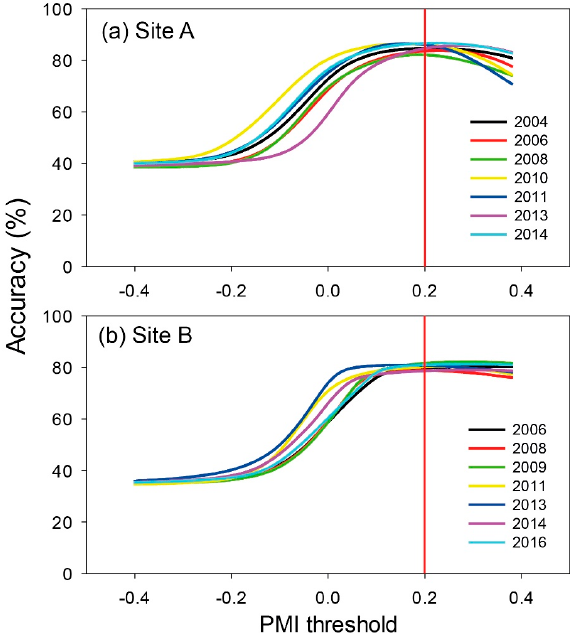
Figure 6. Threshold of Paddy rice Mapping Index (PMI) (near-infrared (NIR) based) and box plot of PMI threshold for 10 years.